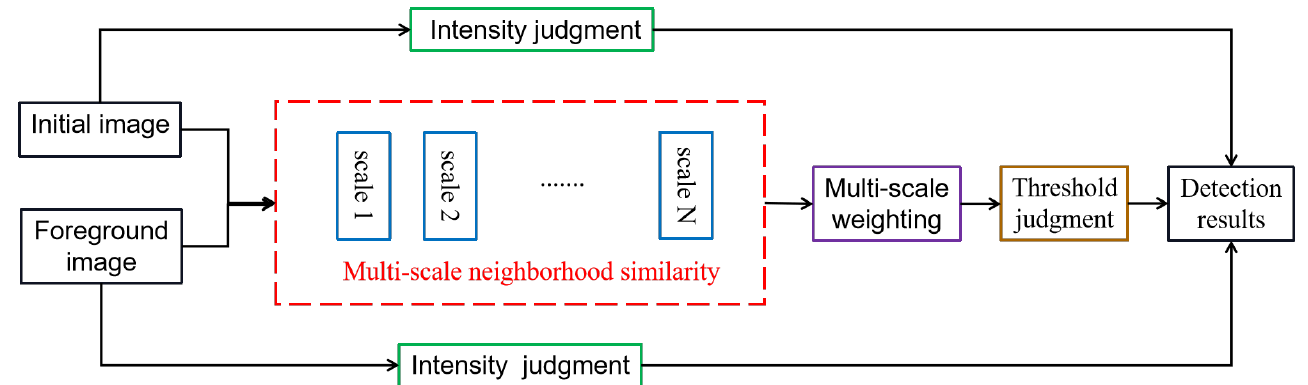
Figure 4. Flow chart of moving target shadow detection based on intensity information and neigh- borhood